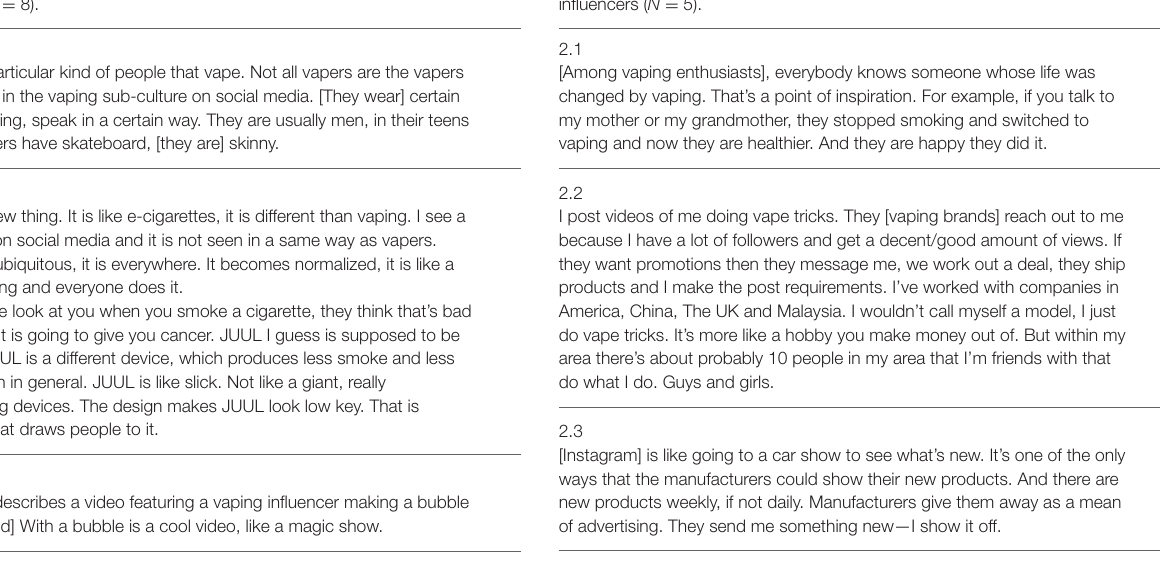
TABLE 4 | Quotes from the interviews with the Instagram vaping influencers ( N =